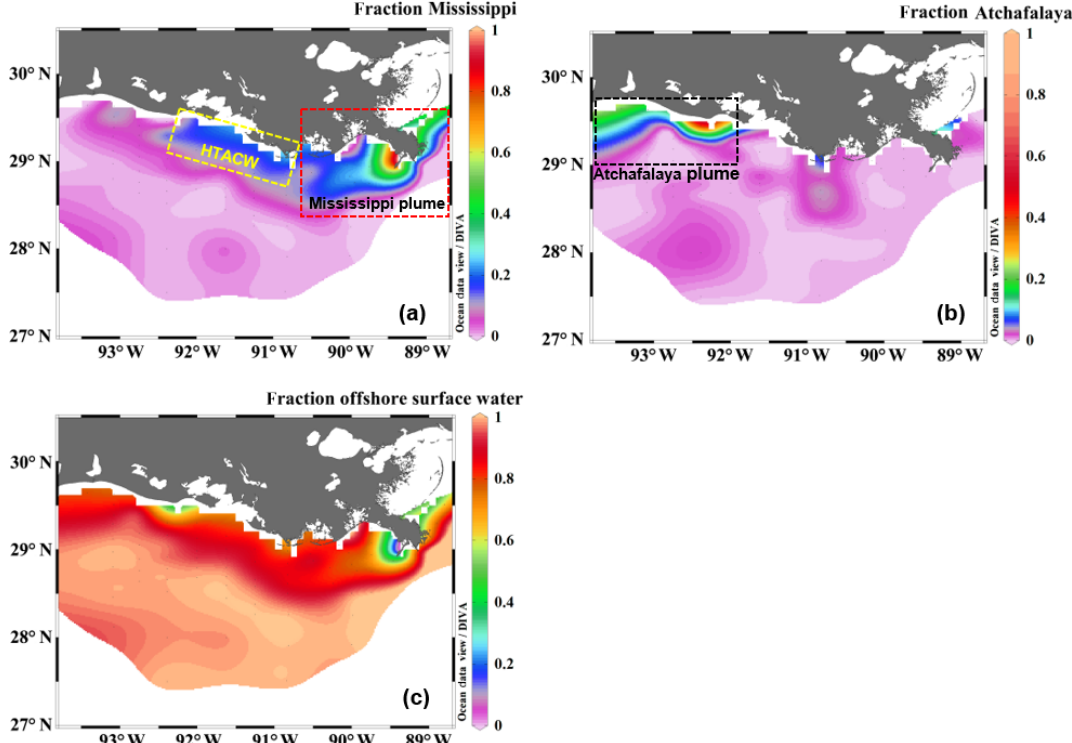
Figure 4. The fractional contribution of (a) the Mississippi River, (b) the Atchafalaya River, and (c) offshore surface water to the surface water of the nGOM estimated from the three-end-member mixing model. The sub-regions shown in (a) and (b) are the Mississippi plume, the high-turbidity Atchafalaya coastal water (HTACW), and the Atchafalaya plume. Figure generated by Ocean Data View (Schlitzer, 2018).